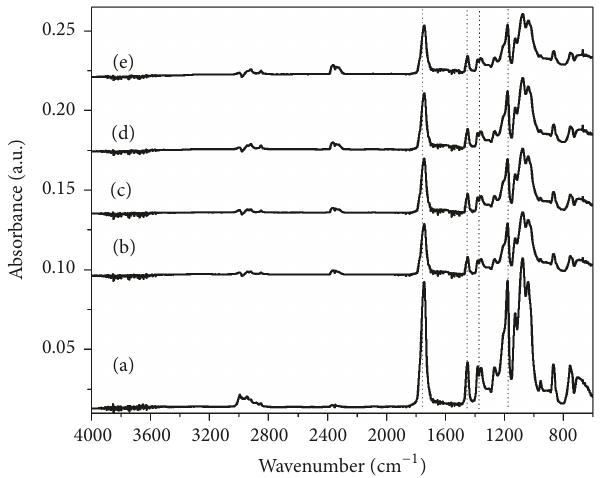
Figure 1: FTIR spectra of PLA-PNSP biocomposites: (a) neat PLA, (b) 5% wt. PNSP defatted, (c) 7.5% wt. PNSP defatted, (d) 5% wt. PNSP untreated, and (e) 7.5% wt. PNSP